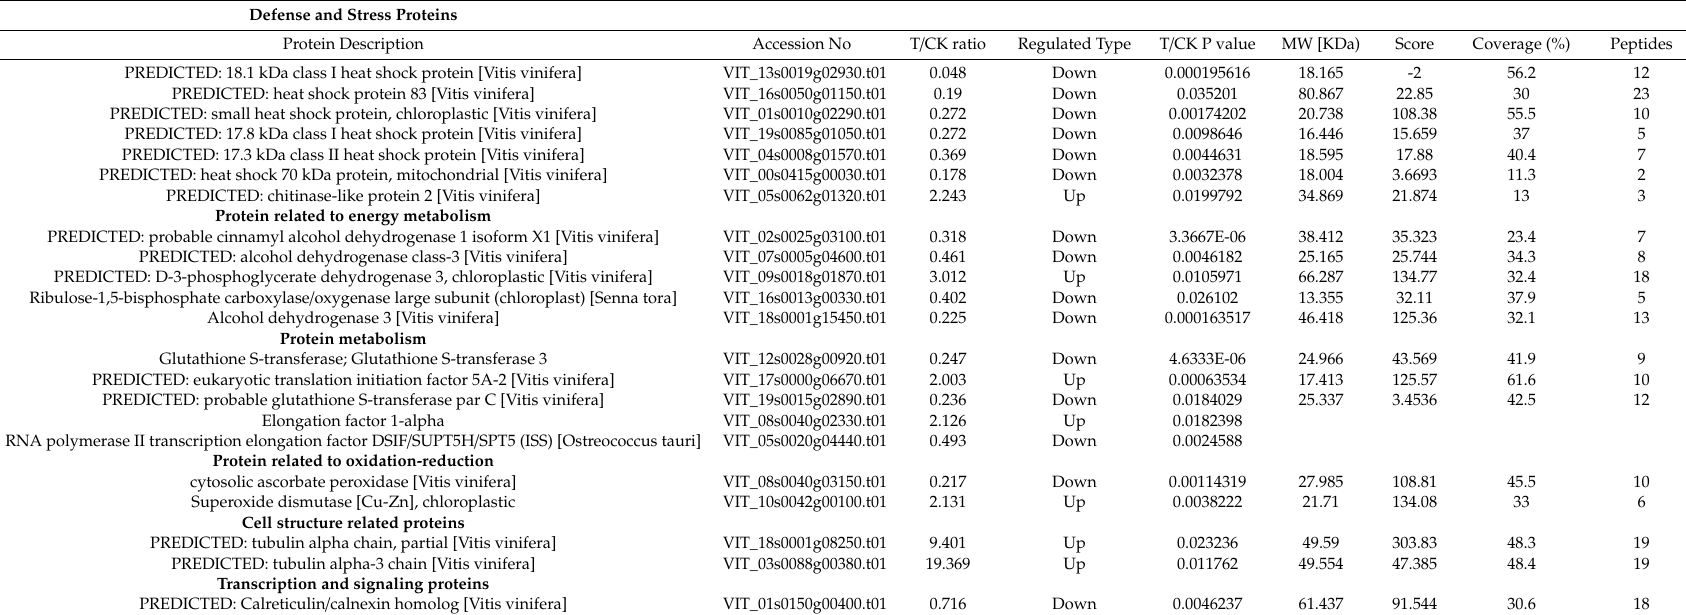
Table 2. Identification of proteins associated with dormancy release treated with HC in